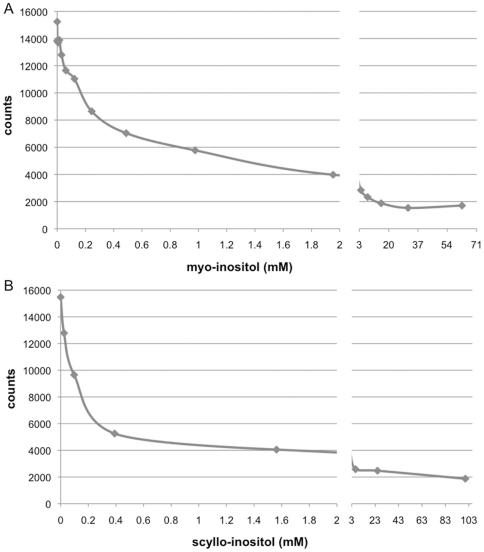

myo-Inositol and scyllo-inositol transport in HEK293 cells.
myo-Inositol testing was conducted in HEK293 cells, by incubating cells for 15 minutes in medium containing 100 µM of myo-inositol-(2-3H) in the presence of increasing concentrations of cold myo-inositol (A). Addition of 10 mM of cold myo-inositol, the concentration used in the competitive transport assays, resulted in a near maximal inhibition of myo-inositol-(2-3H) transport in these cells. scyllo-Inositol testing was conducted over a period of 3 hours in these cells, due to slower uptake rates (B). Once again, 10 mM of cold scyllo-inositol produced near maximal inhibition of scyllo-inositol-(2-3H). (n = 3 wells per concentration).